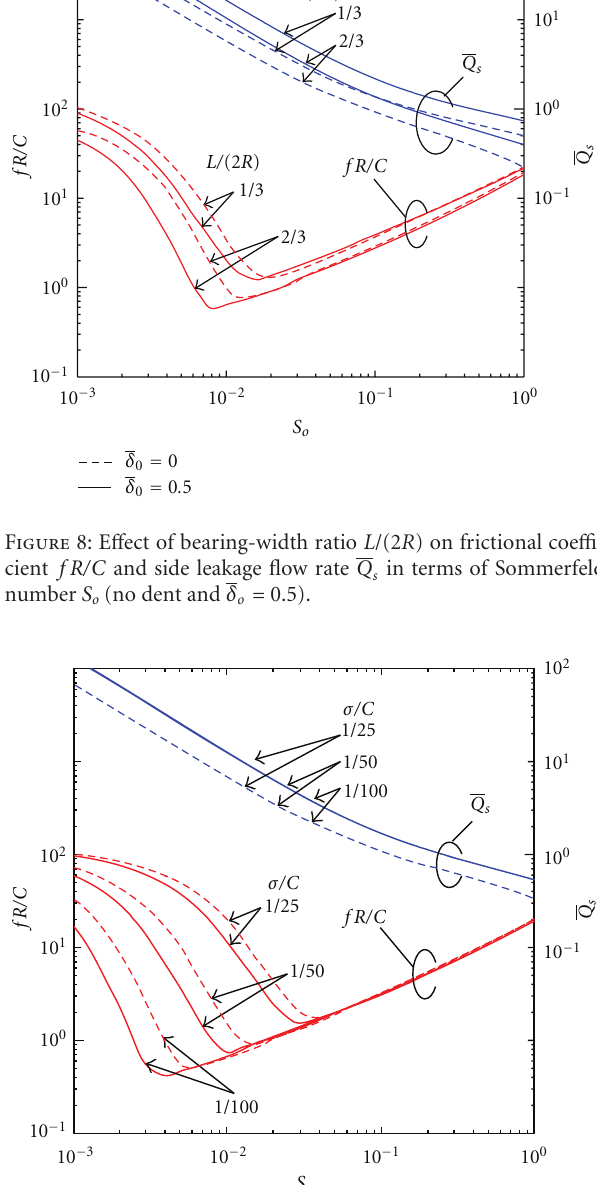
in terms of Sommerfeld number s